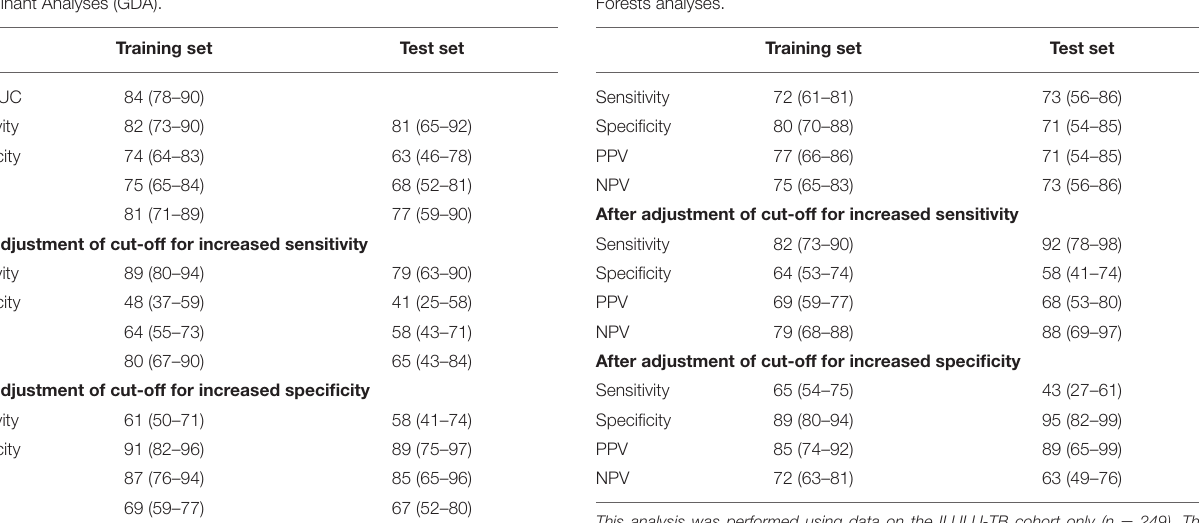
TABLE 7 | Performance of a new 22-protein signature derived from Random Forests analyses.